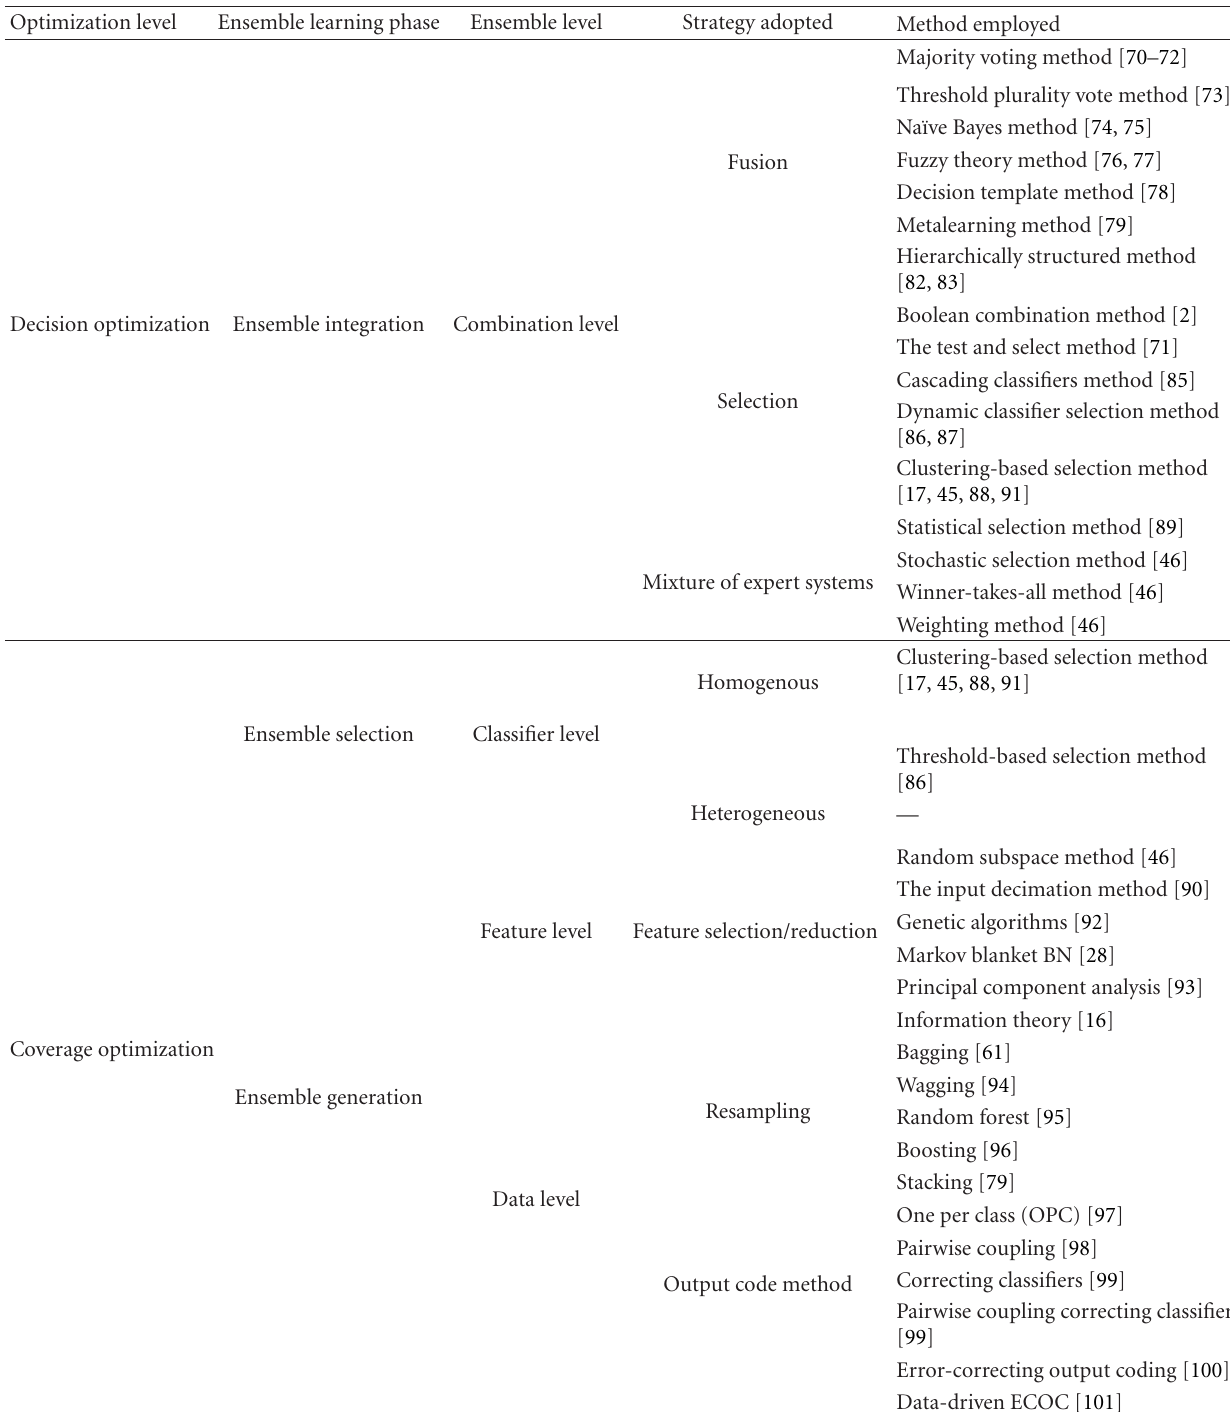
Table 1: Summary of